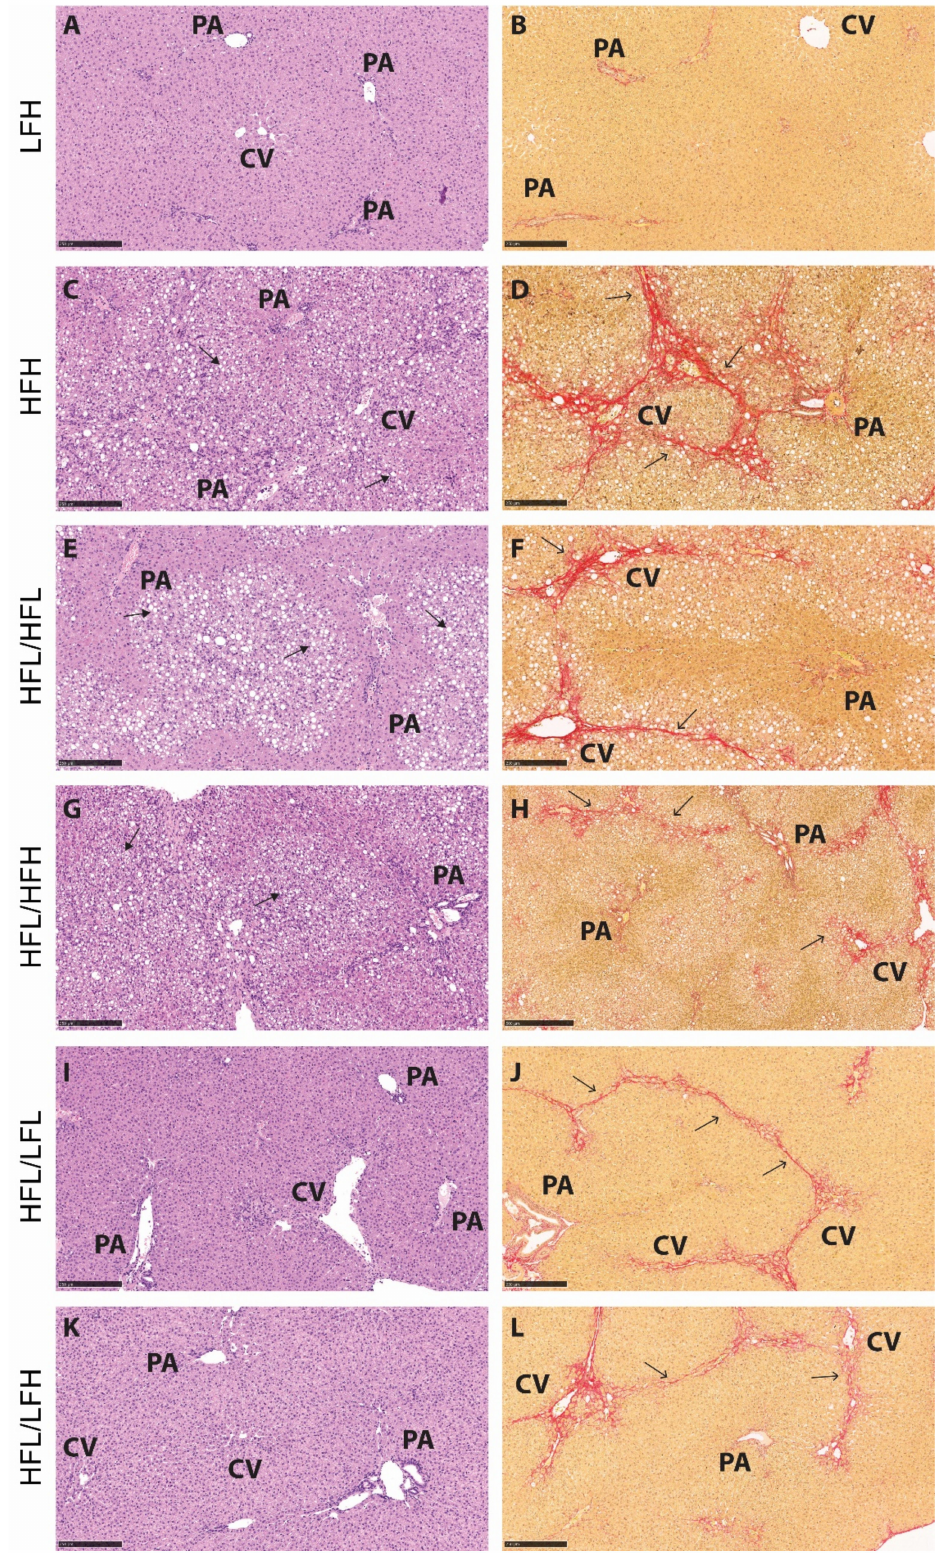
Figure 6. Representative histological images for each group at the 32-week time point. ( A , C , E , G , I , K ): Hematoxylin and eosin stain. Scale bar shows 250 µ m. ( B , D , F , H , J , L ): Picrosirius red stain. Scale bar shows 250 µ m. Solid arrows indicate lipid vacuoles (macro- and microvesicular steatosis), and open arrows indicate fibrosis (in red). CV: central vein, PA: portal area, HFL: high fat low vitC, HFH: high fat high vitC, LFL: low fat low vitC, LFH: low fat high